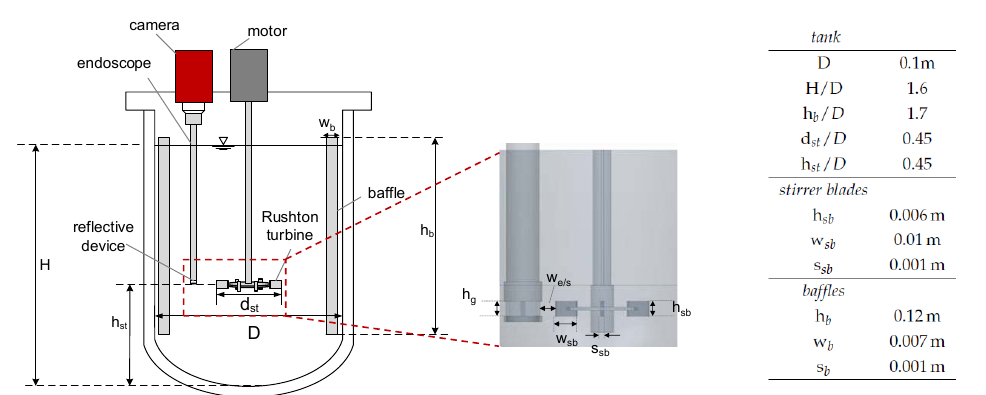
Figure 3. Experimental setup, baffled reactor equipped with a Rushton turbine and in situ endoscope technique and enlarged view of the stirrer and the endoscope with the reflective Teflon device. The corresponding dimensions of the stirred tank set up including baffles (b) and stirrer blades (sb) are shown in the